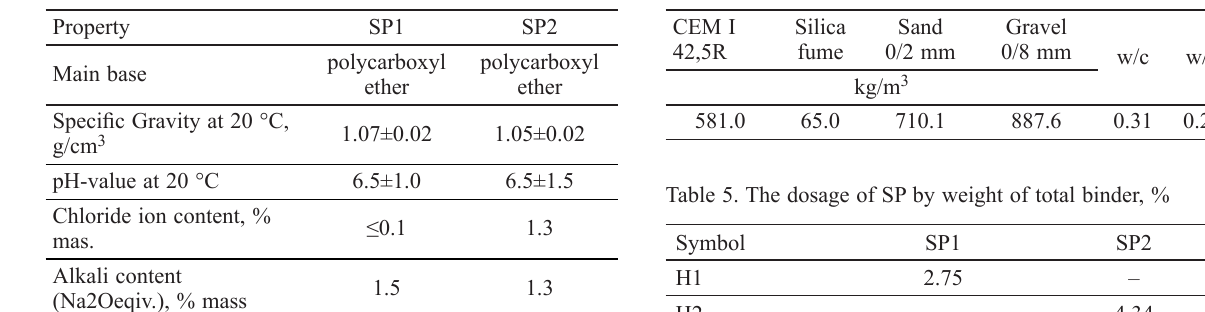
Table 4. The components of HPSCC